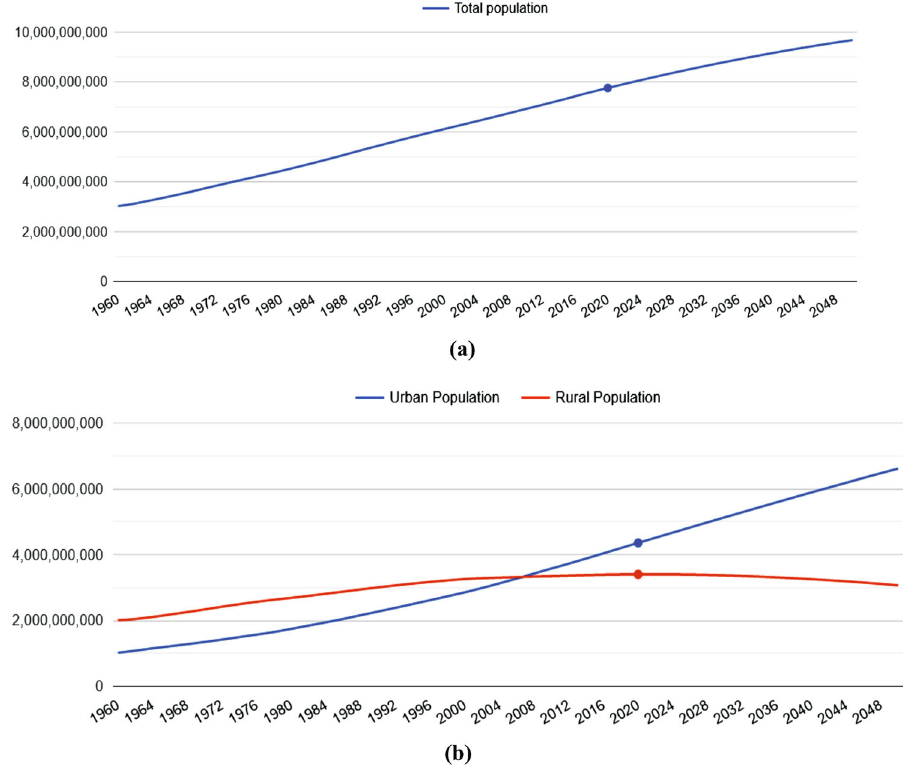
Fig. 1 Change in global population statistics from 1960 to expected in 2048. Graph showing ( a ) tremendous increase in total population ( b ) increase in urbanisation while decline in rural population. Open Source: